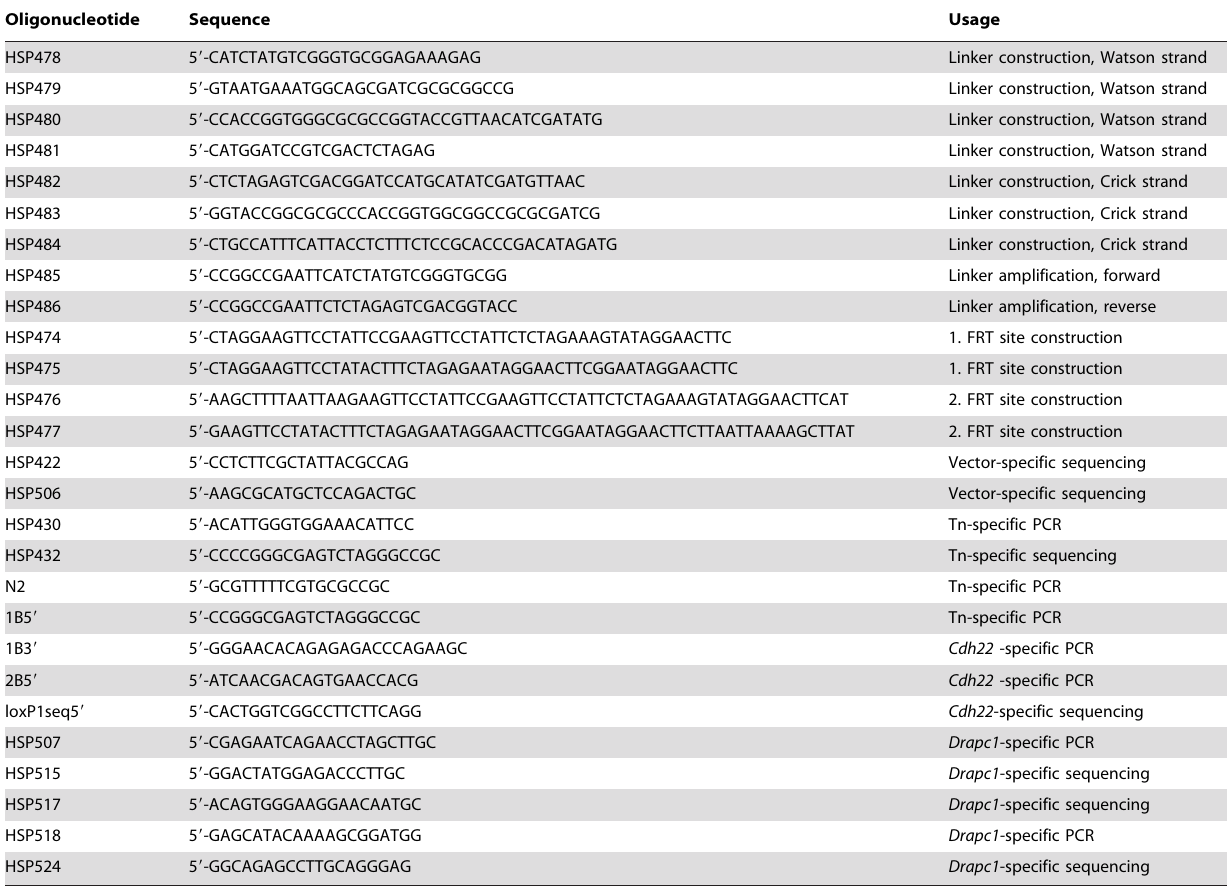
Oligonucleotide